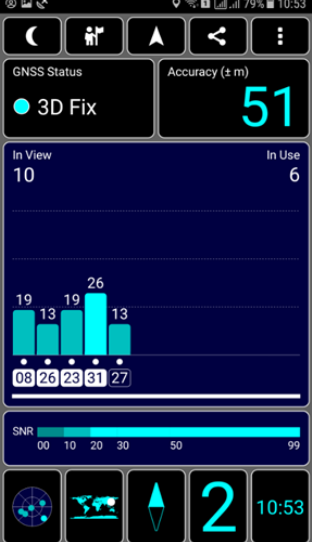
Figure 5. GPS signal determination application.